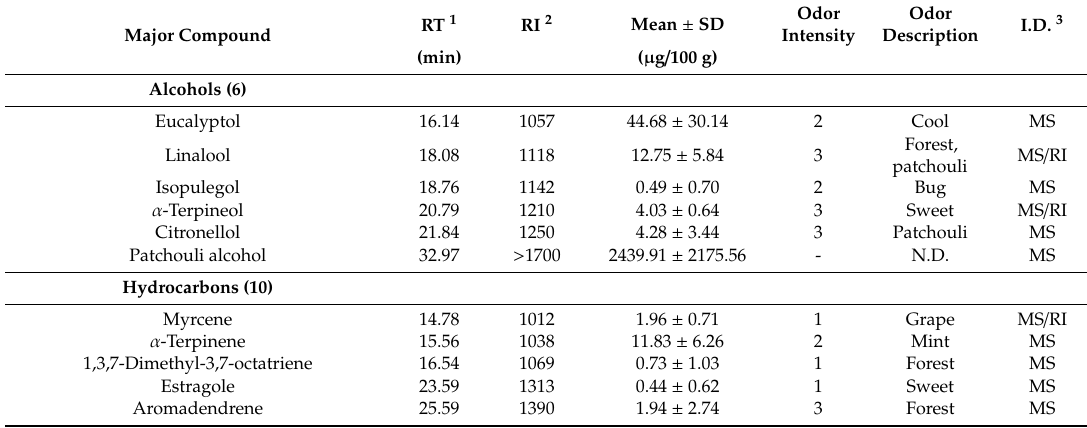
Table 1. Volatile compounds of patchouli essential oil by GC / MS and GC-olfactormetry